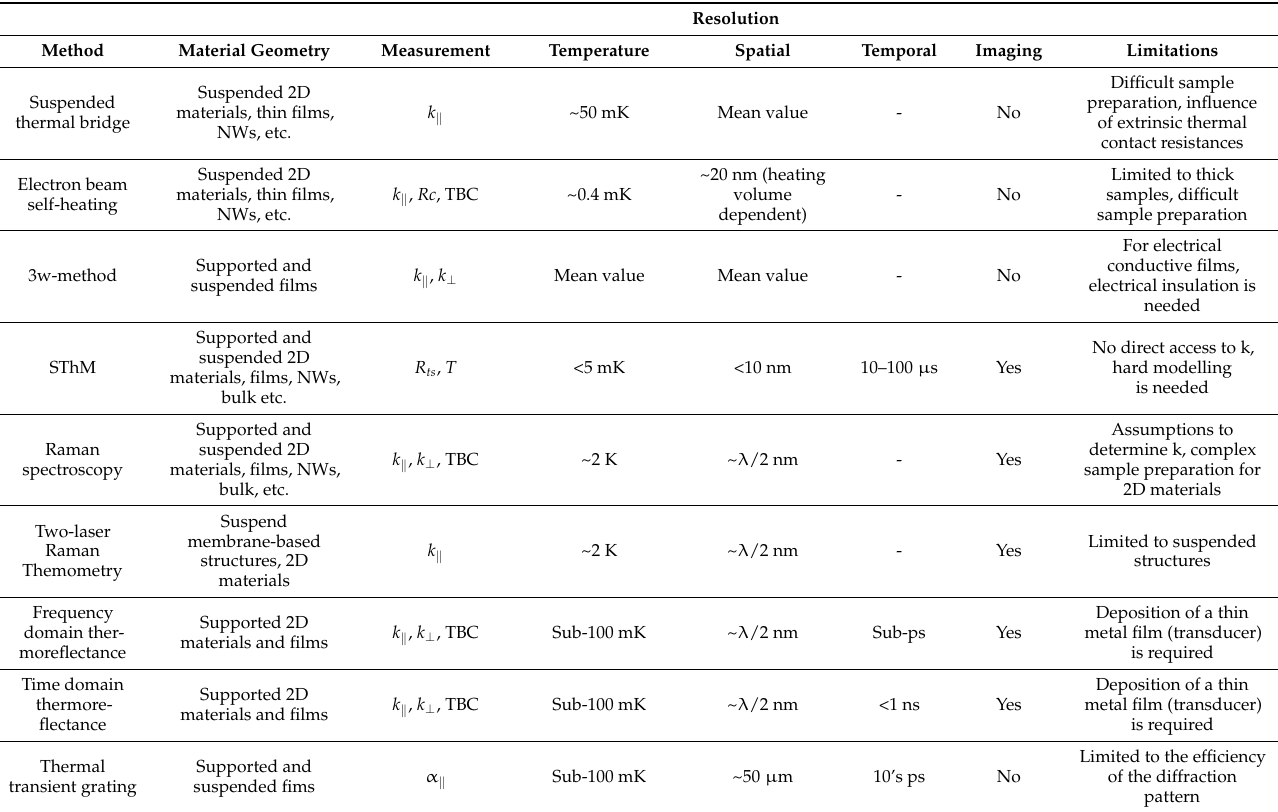
Table 1. Summary of high-resolution thermal characterization